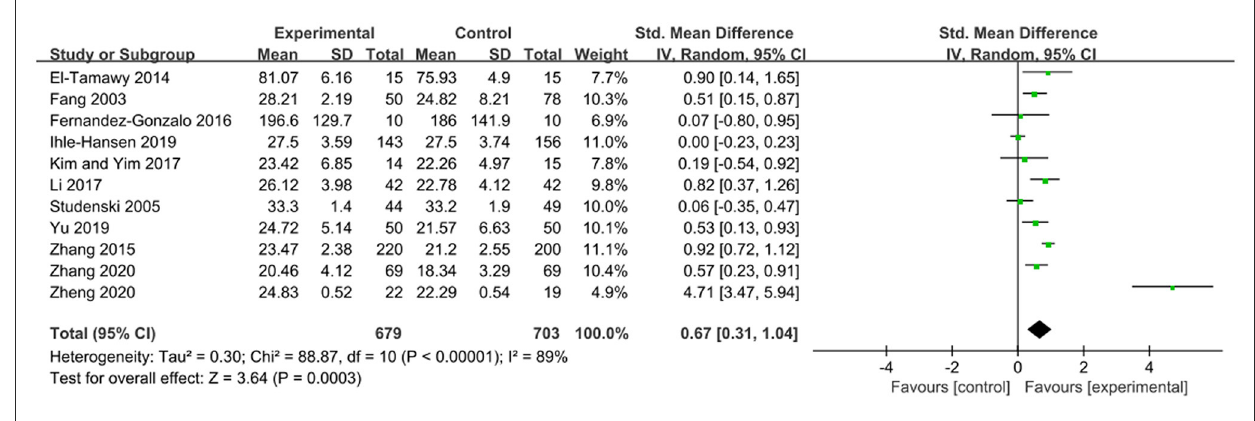
FIGURE3 Effects of exercise therapy on cognitive function in patients with PSCI.